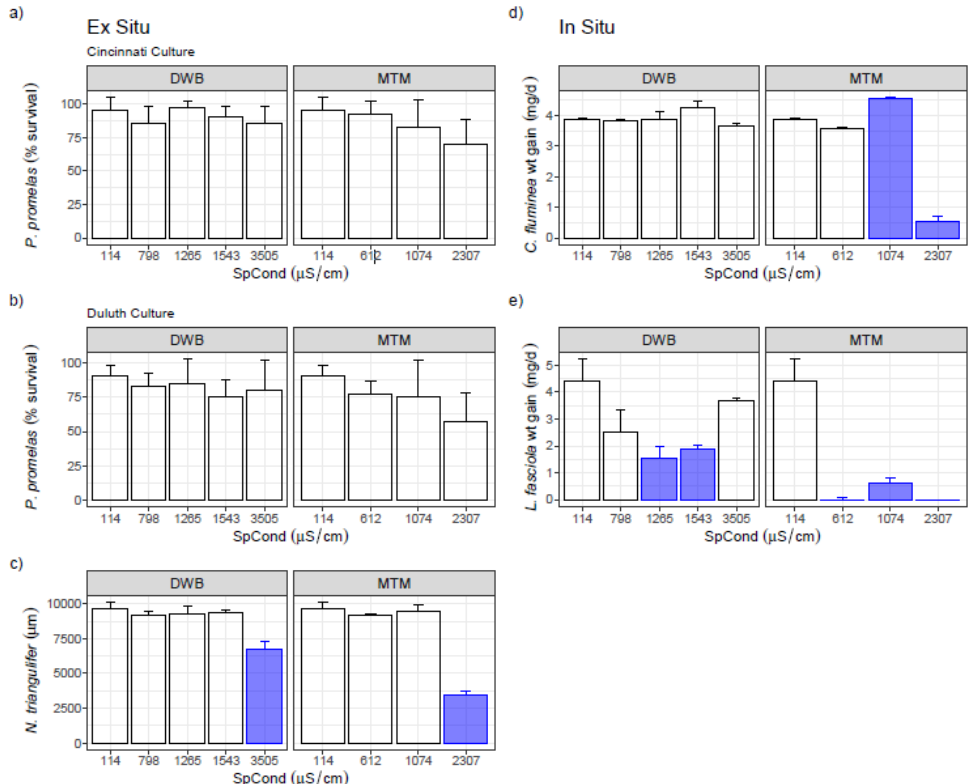
Figure 3. Single-Species ex situ / in situ test results for the DWB and MTM dosing recipes. Ex situ tests (left panel) and in situ tests (right panel): ( a , b ) for P. promelas ; from Cincinnati and Duluth cultures, respectively (see text); ( c ) N. triangulifer ; ( d ) C. fluminea ; and ( e ) L. fasciola . Data are means per dose tested ± 1 sd, with n = 4 and 2 per dose for ex situ and in situ, respectively. Colored bars represent significant difference from control ( p < 0.05) per Dunnett’s test.